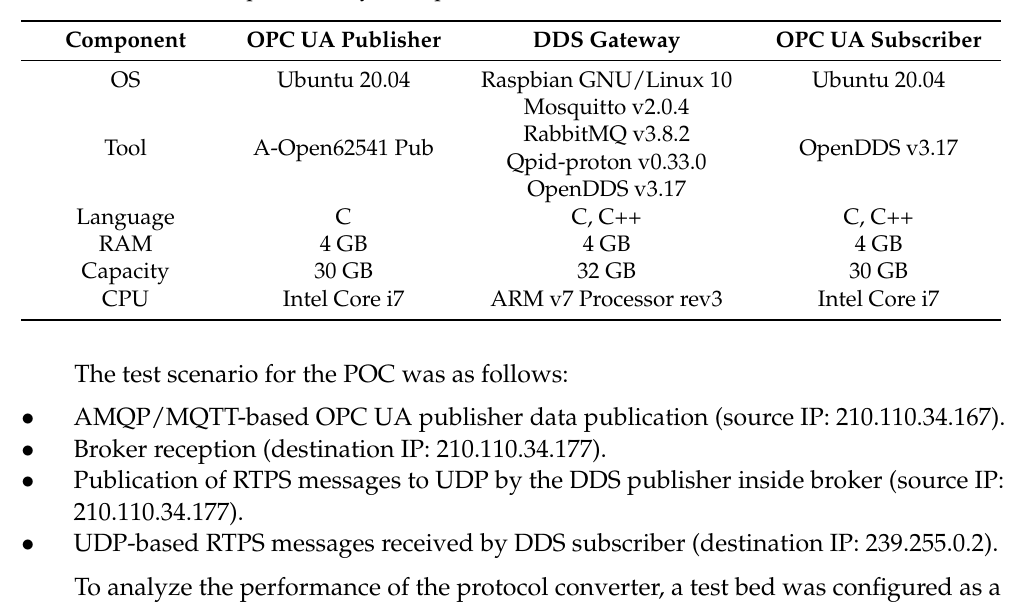
Table 7. Proof of concept testbed system